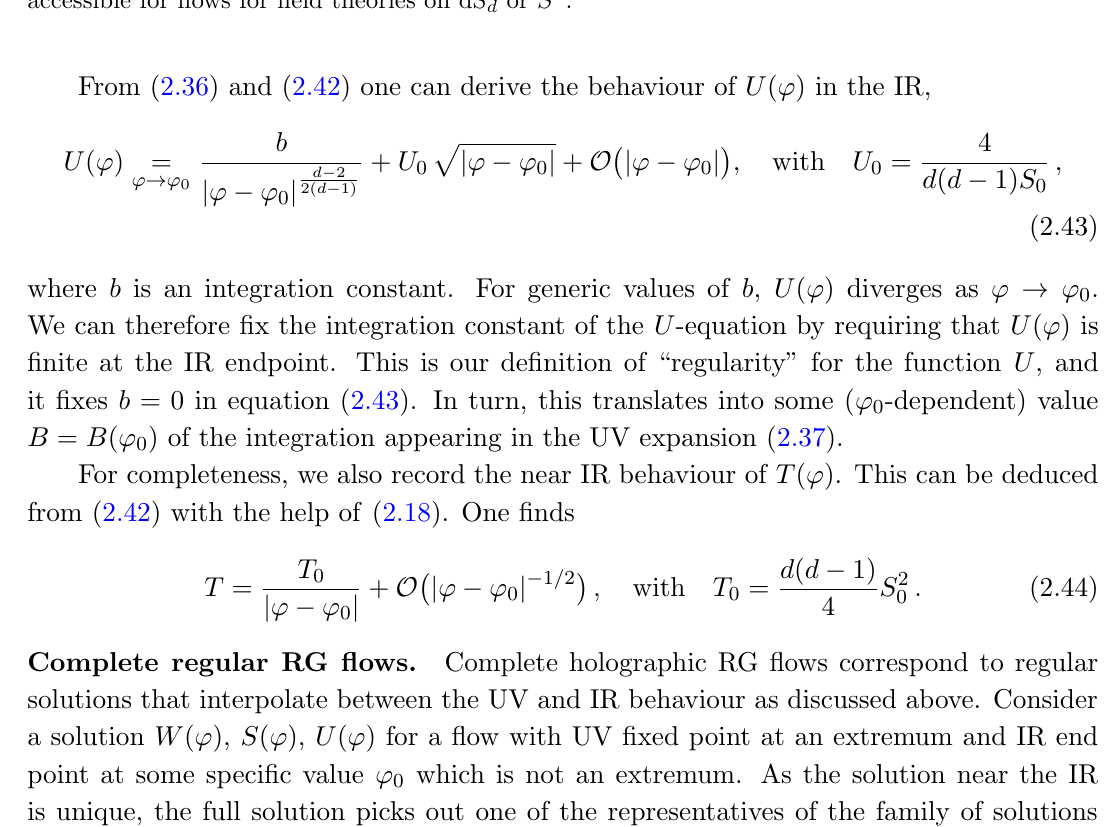
Figure 3. Holographic RG (cid:13)ow solutions for the potential (2.45). Note the family of solutions W C; R ( ’ ) in the vicinity of a UV (cid:12)xed point located at the maximum of the potential. For a given IR end point ’ 0 only one of these solutions can be completed, resulting in a holographic RG (cid:13)ow for theories with a speci(cid:12)c combination of ( C; R ). The shaded region below the blue curve is not accessible for (cid:13)ows for (cid:12)eld theories on dS d or S d